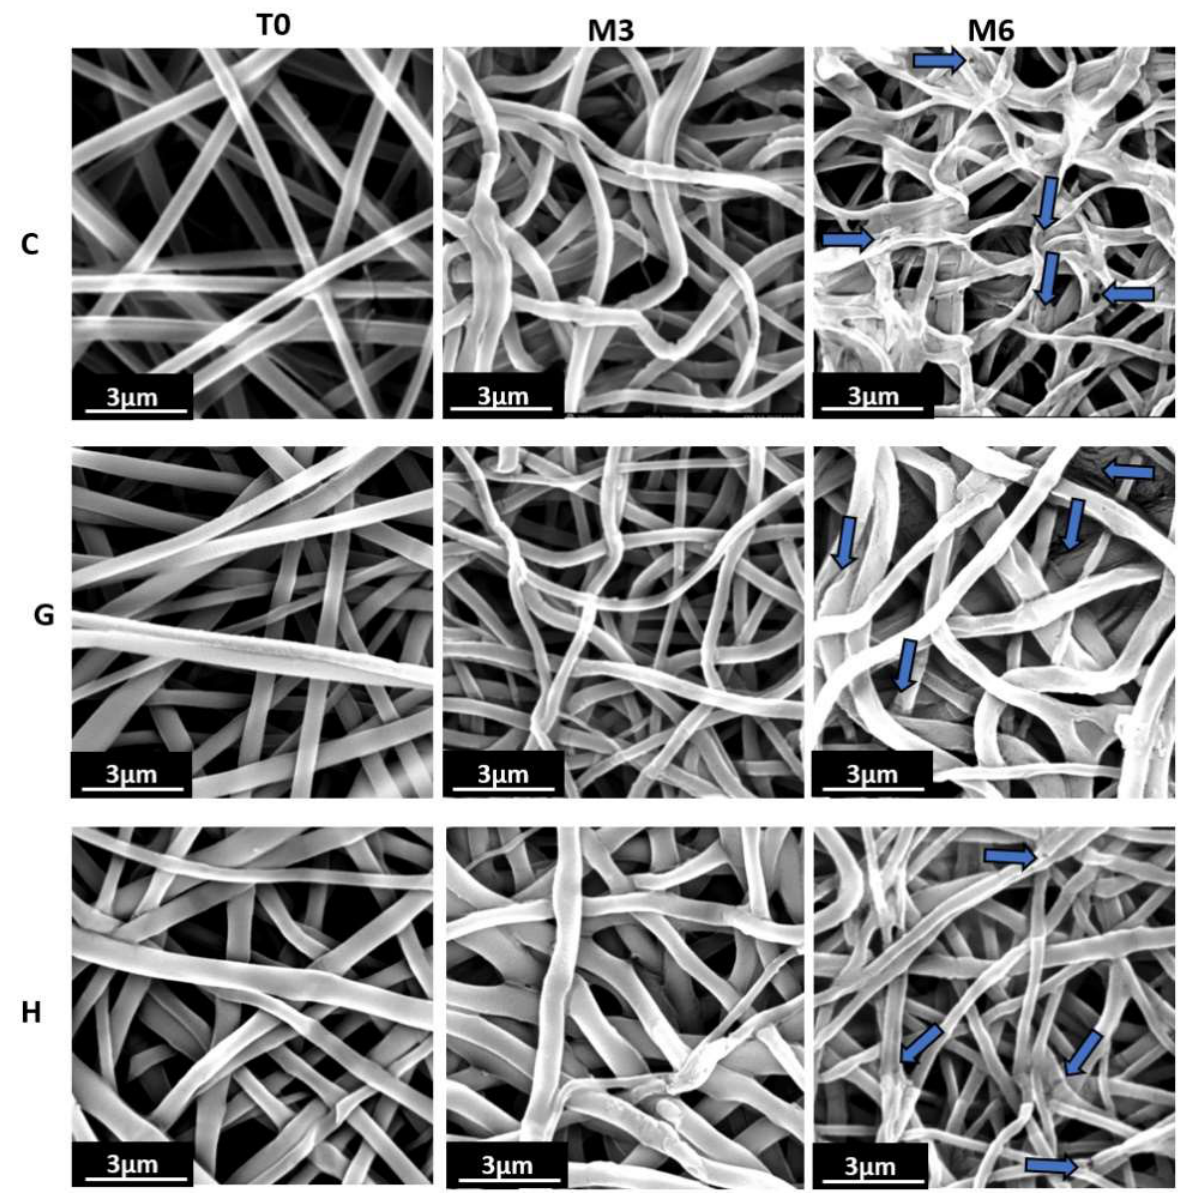
Figure 4. Morphology of samples C, G and H before (T0) and after 3 and 6 months of degradation. The blue arrows show degradation cracks on the surface of nanofibers at month six.